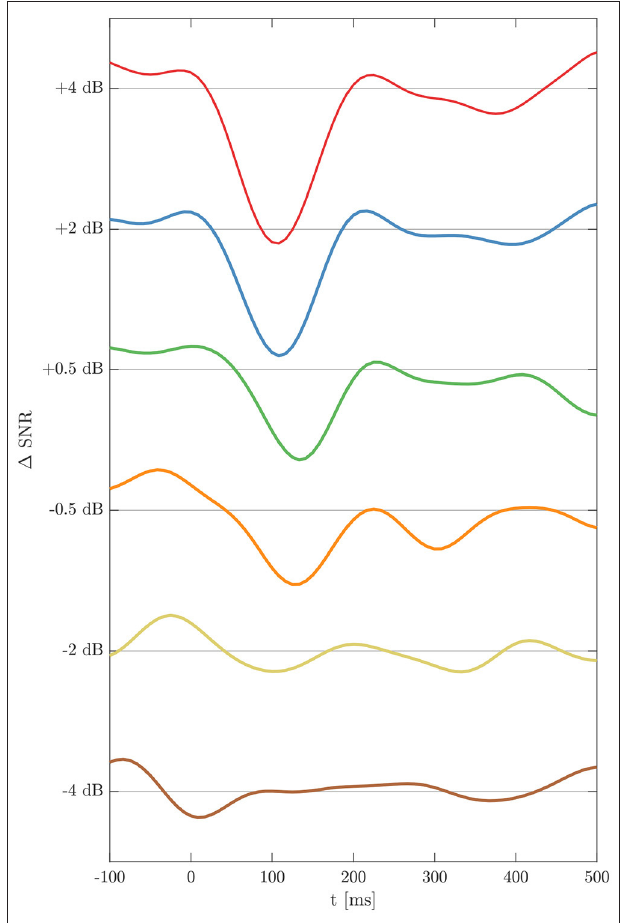
FIGURE 3 | Temporal response functions for the six 1 SNR conditions, calculated as grand average over all subjects for electrode C3. TRFs exhibit peaks N1 TRF and P2 TRF down to a 1 SNR of –2